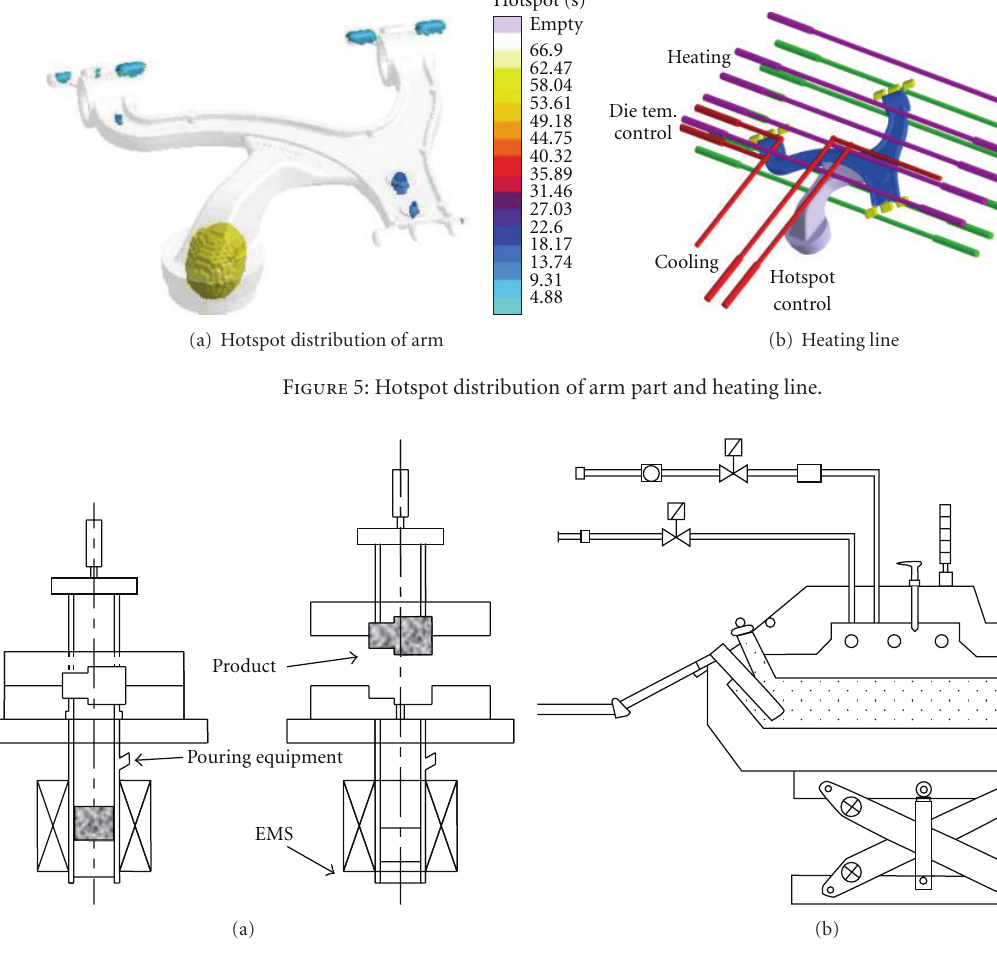
Figure 6: Schematic diagram for casting with EMS: (a) medium vertical die casting press; (b) continuous pouring of molten alloy (Al dosing